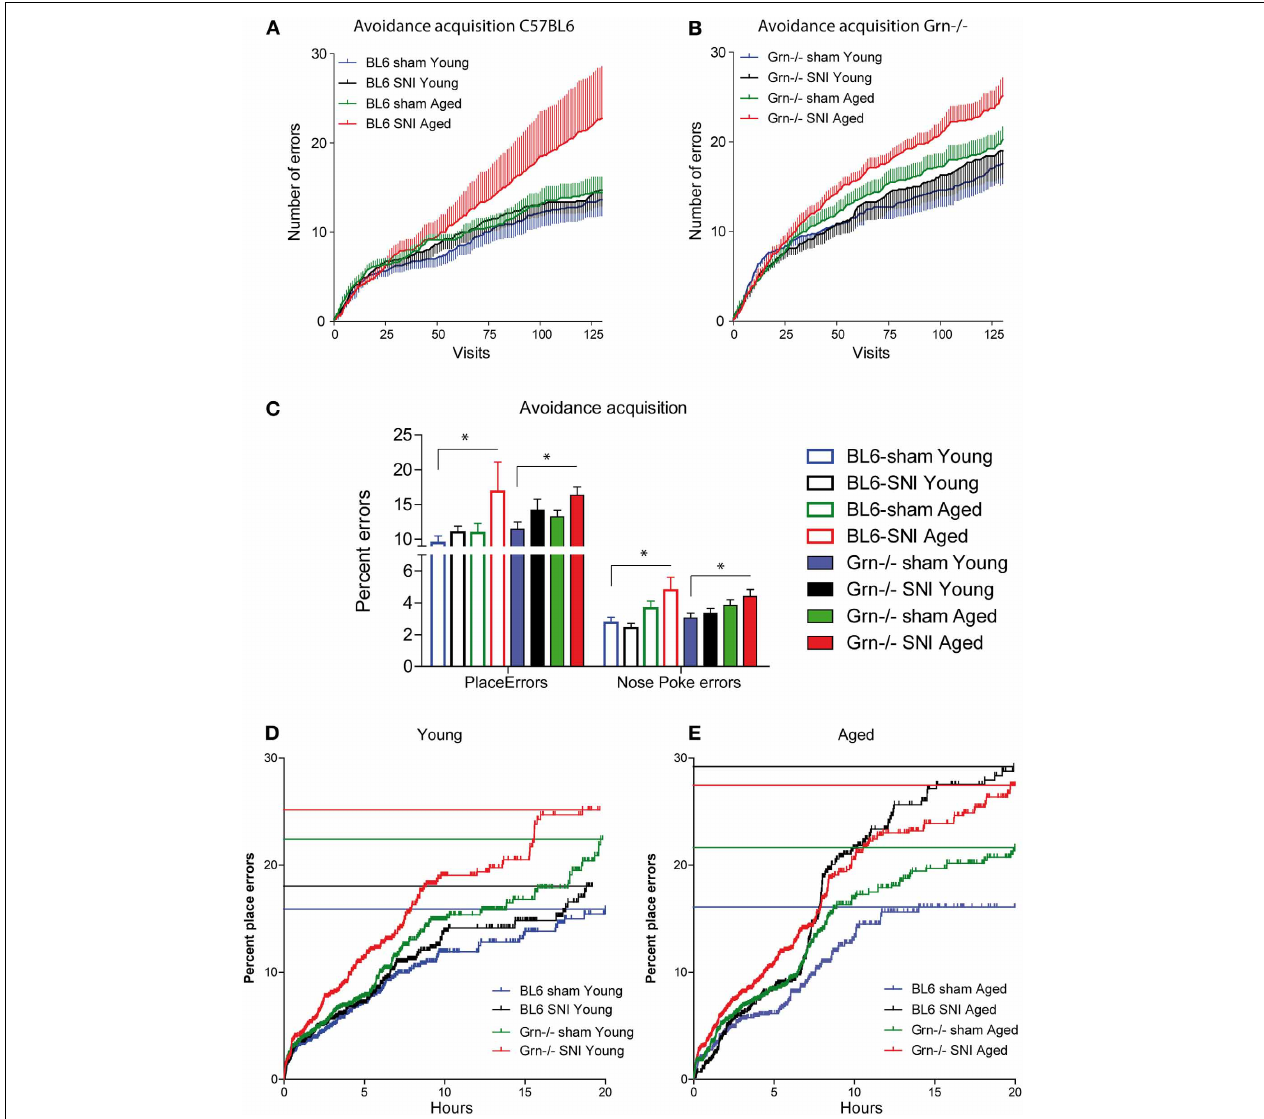
FIGURE 3 | Avoidance acquisition in the IntelliCage in young and aged C57BL6/J and progranulin deficient (Grn − / − ) mice. (A,B) Mean ± s.e.m cumulative place errors per visit number in sham and SNI-treated (Spared Nerve Injury of the sciatic nerve) in young and aged C57BL6/J and progranulin deficient mice ( n = 8 per group). (C) Group means of error percentages during the 24 h-avoidance acquisition period for place errors and nosepoke (NP) errors. The asterisks denote significant differences vs. the